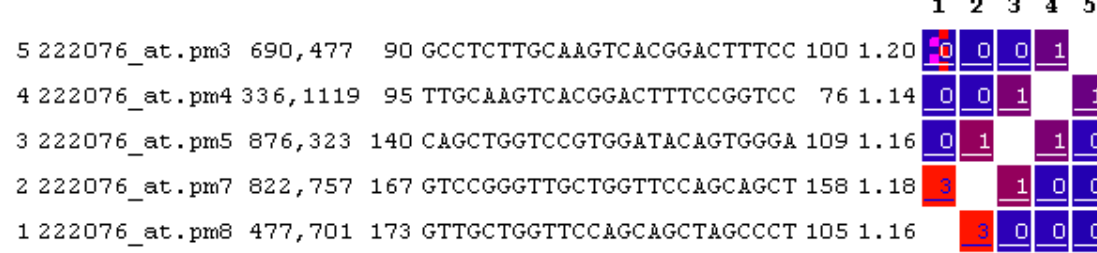
Figure 2. The antisense probes from probeset 222076_at are not correlated. The columns indicate the probe order in the heatmap, probe identifier (in which pm means perfect match, followed by the order of the probe in its probeset), x-coordinate of probe location on the array, y-coordinate of probe location on the array, interrogation position of probe on Affymetrix consensus sequence, probe sequence, geometric mean of the intensities across GEO, and standard deviation (of the logs of intensities), respectively. The numbers in each of the cells represent the rounded correlation x 10.